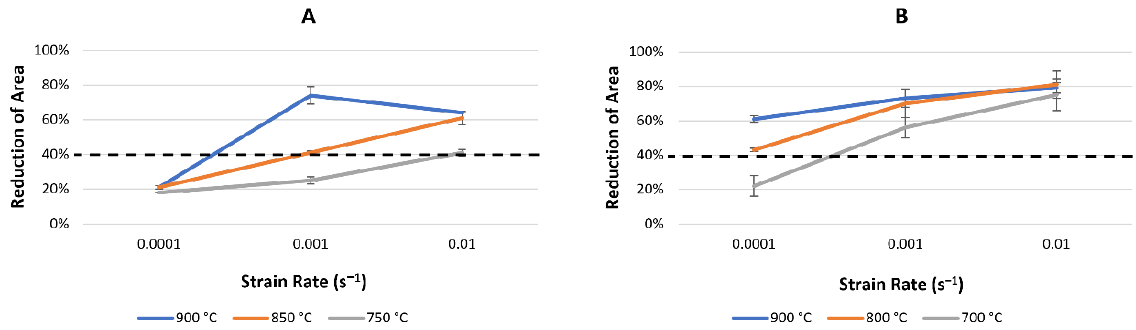
Figure 2. Influence of the strain rate on the hot ductility behavior of steel A and B .